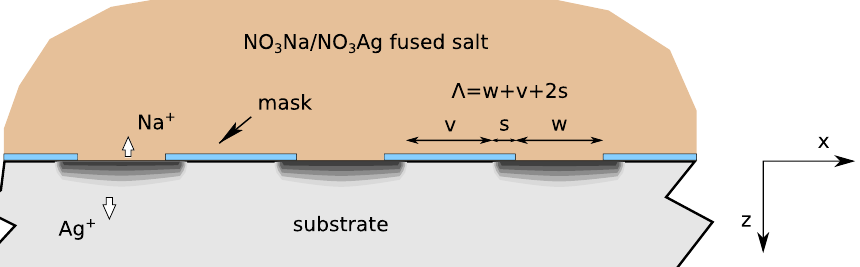
Figure 1. Scheme of the fabrication of an ion-exchanged grating. s and Λ indicate the transition region (or side diffusion) and the period of the grating,